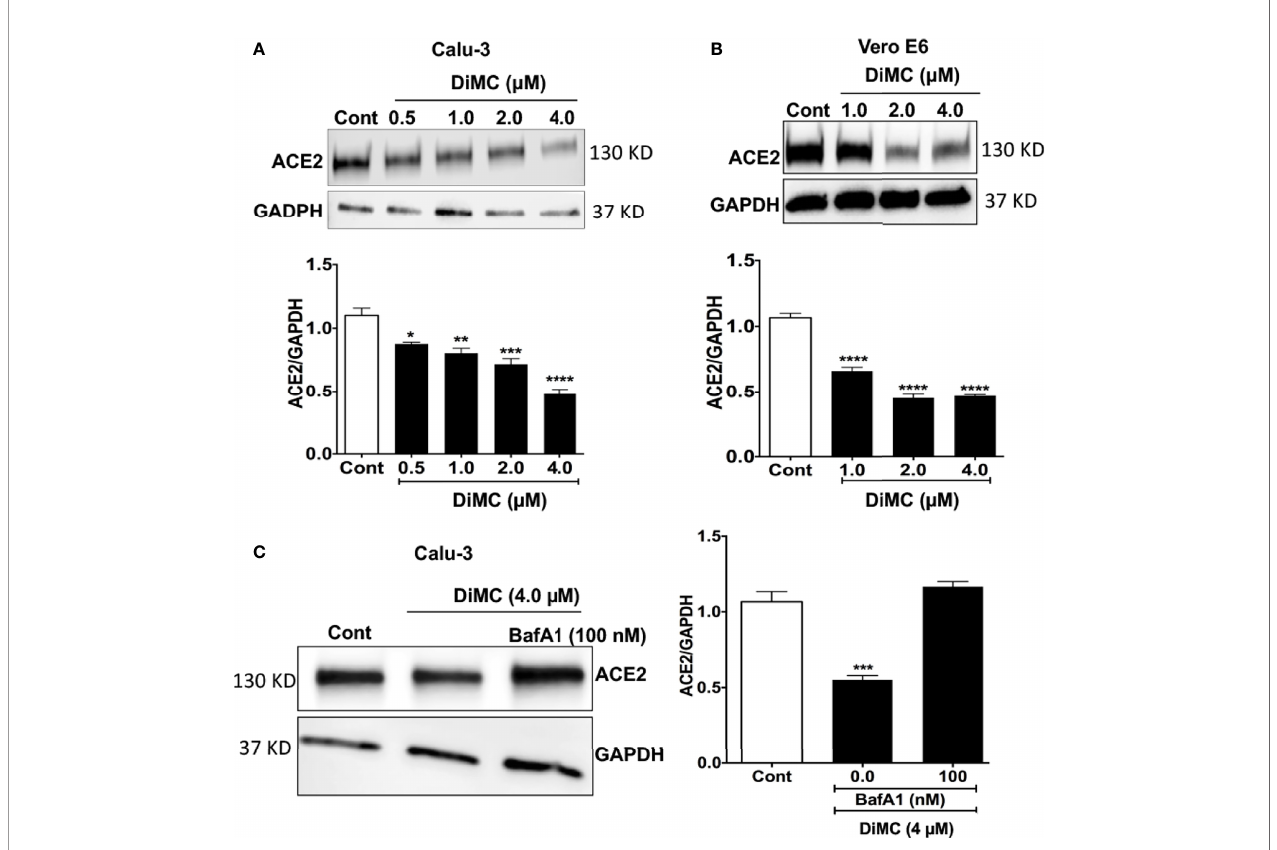
FIGURE 2 | DiMC decreased protein expression levels of ACE2: (A, B) DiMC treatment (1.0, 2.0, and 4.0 µM for 24 h) decreased protein expression levels of ACE2 in a concentration-dependent manner in both Calu-3 (A) and Vero E6 (B) cells (n = 3, *p <0.05, **p <0.01, ***p <0.001, ****p <0.0001). (C) Inhibiting vacuolar- ATPase with ba fi lomycin A1 (100 nM) prevented DiMC (4.0 µM for 18 h)-induced decreases of ACE2 protein expression levels in Calu-3 cells (n = 3, ***p